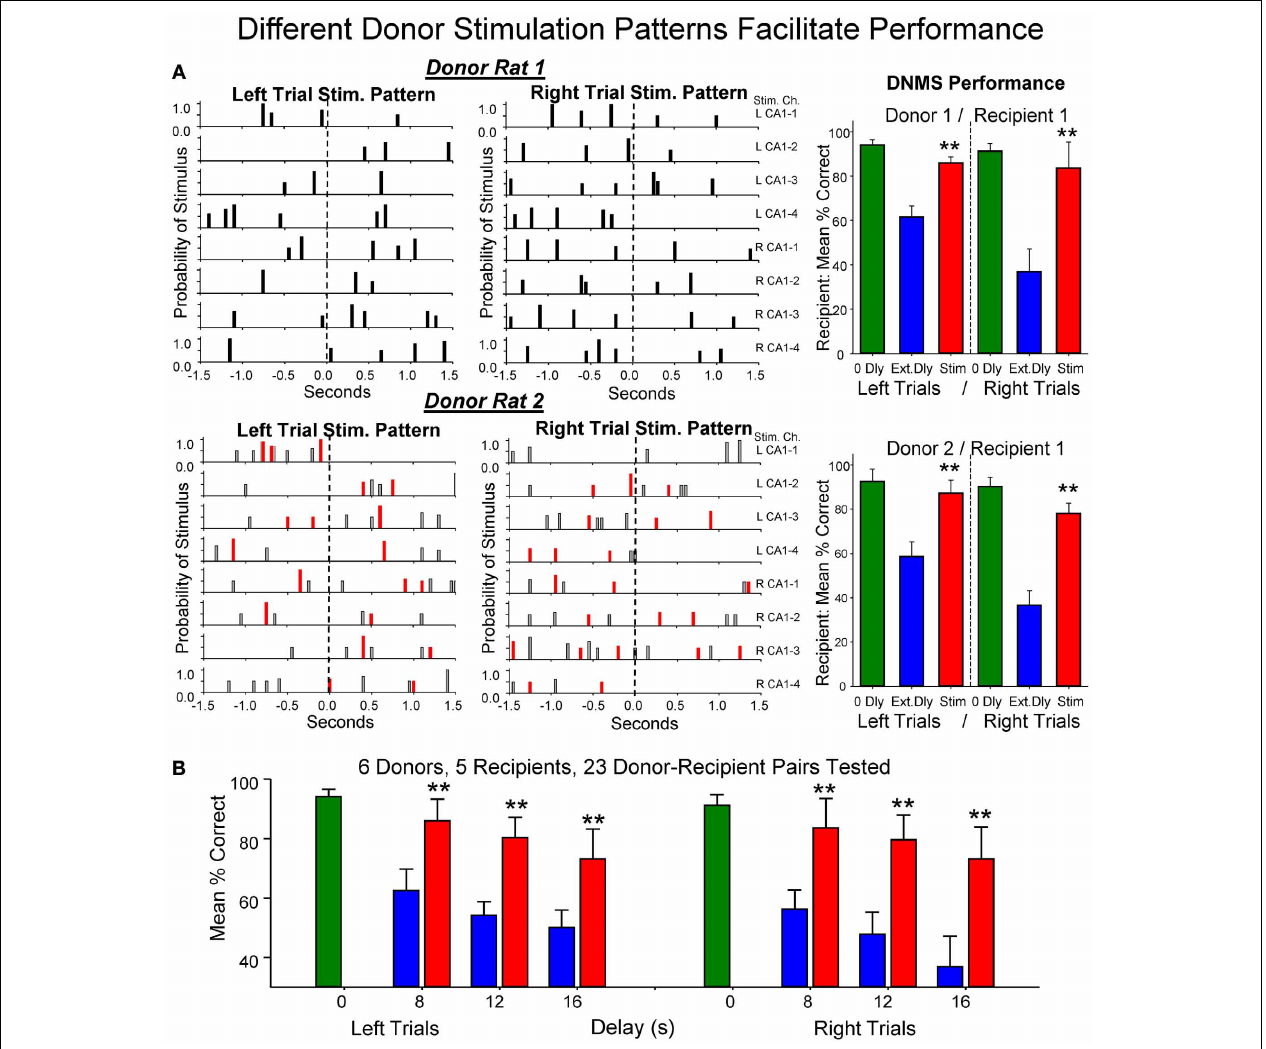
FIGURE 5 | Enhancement of performance of the same recipient rat by different donor rats. (A) Left: Delivered MIMO SR CA1 stimulation patterns showed for left and right lever trials from Donor rat 1 (upper) and Donor rat 2 (lower). Red marks in Donor rat 2 patterns reflect occurrences of identical pulses delivered in Donor rat 1 pattern (above) for direct comparison of the two SR Stimulation patterns delivered to the same Recipient rat on different trials. Right: Overall performance of the same Recipient rat for sessions in which SR Stimulation (Stim) on delay trials was contributed by Donor rat 1 (upper) and Donor rat 2 (lower) for left and right Sample lever trials summed over all delays (red) compared with delay